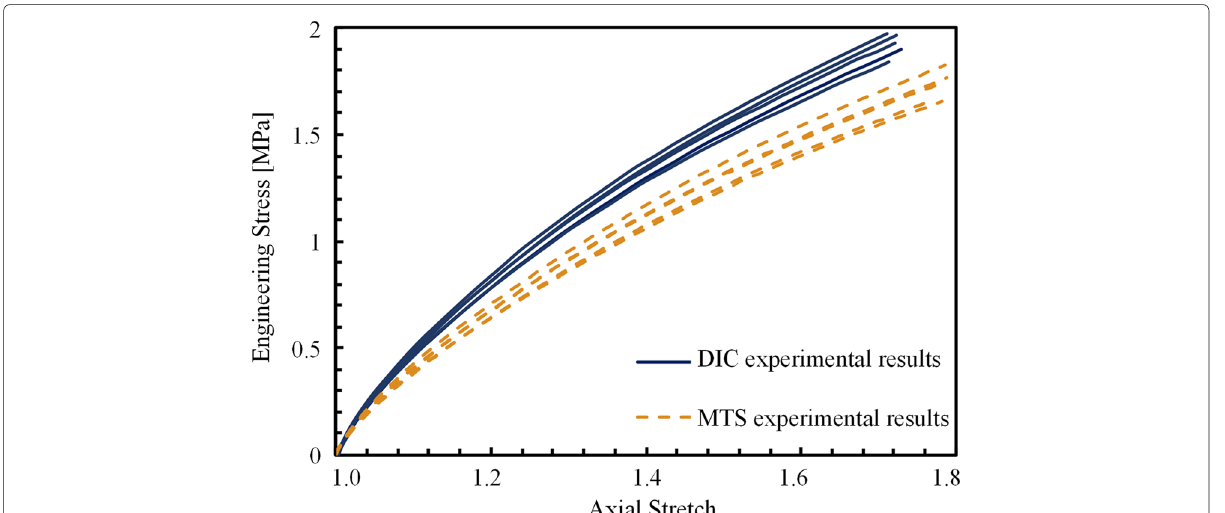
Fig. 5 Uni-axial testing results for experiments performed at a nominal strain rate of 1 × 10 − 3 s − 1